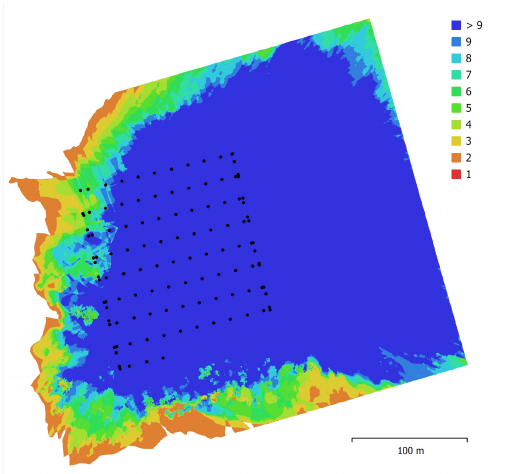
Figure 4 . Camera locations and image